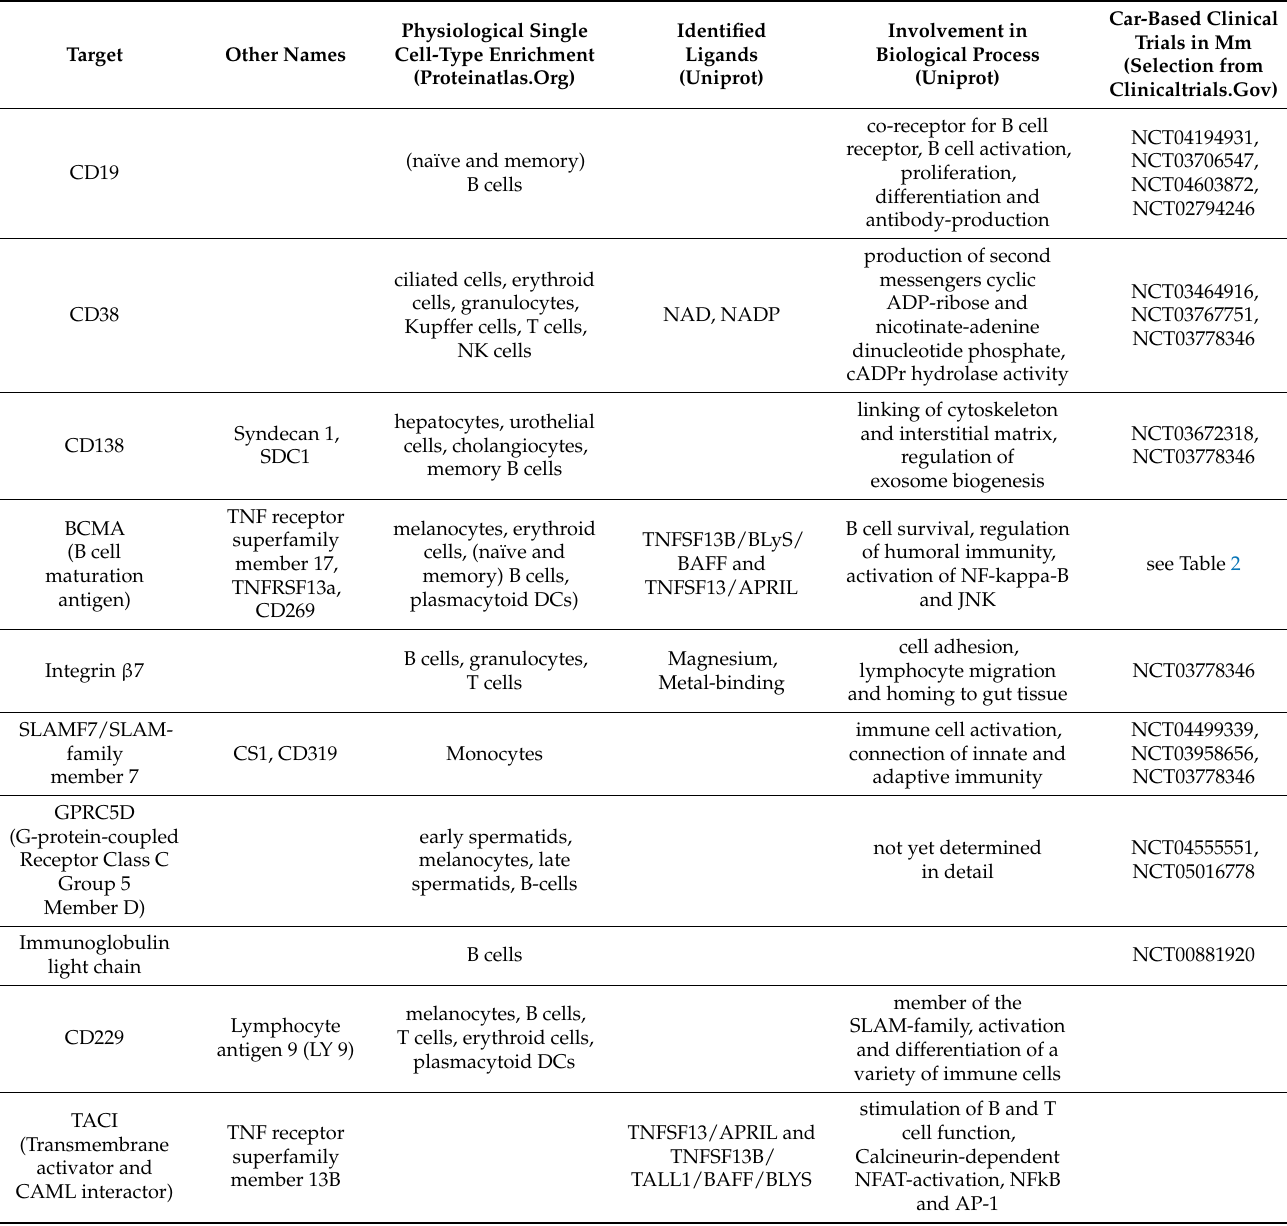
Table 1. Surface antigens in MM: potential targets for CAR-based